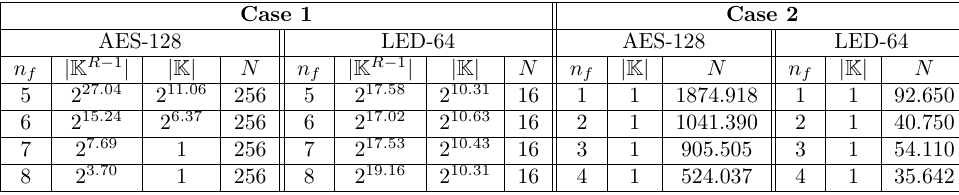
Table 7: Experimental Results of AES-128 and LED-64